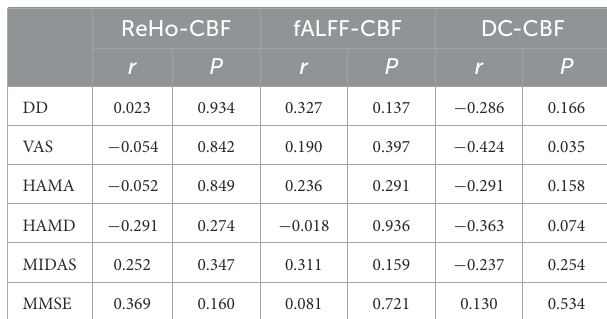
TABLE 4 Correlation between NVC connectivity of the brain regions with altered NVC and the clinical characteristics in